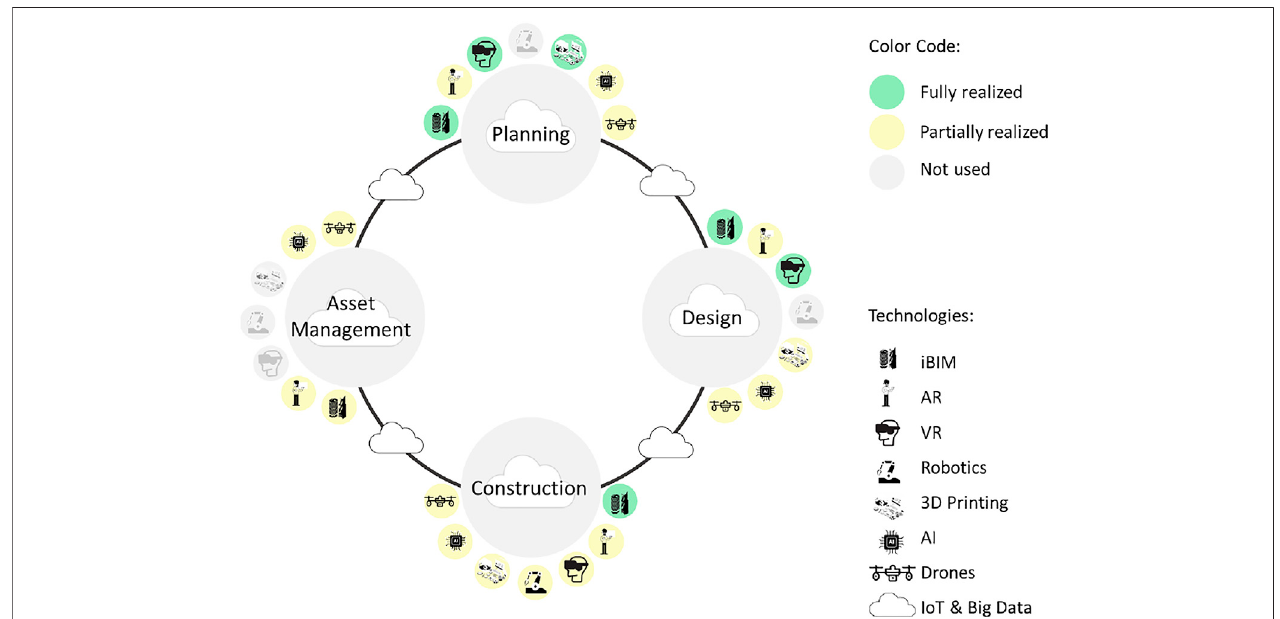
FIGURE 2 | Construction 4.0 lifecycle and technology